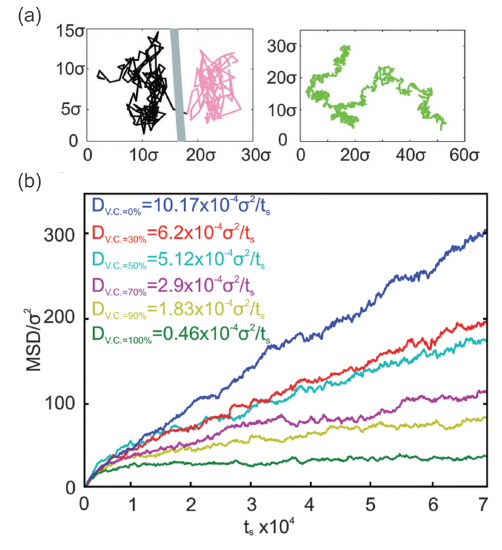
Figure 8. ( a ) Trajectory of a mobile band-3 protein in an RBC membrane undergoing hop diffusion ( left ). Trajectory of a mobile band-3 protein in a lipid bilayer undergoing normal diffusion ( right ) obtained from CGMD simulations [140]. ( b ) Mean square displacement (MSD) of mobile band-3 proteins with varying vertical connectivities between band-3 proteins and spectrin filaments. Reproduced from reference [140] with